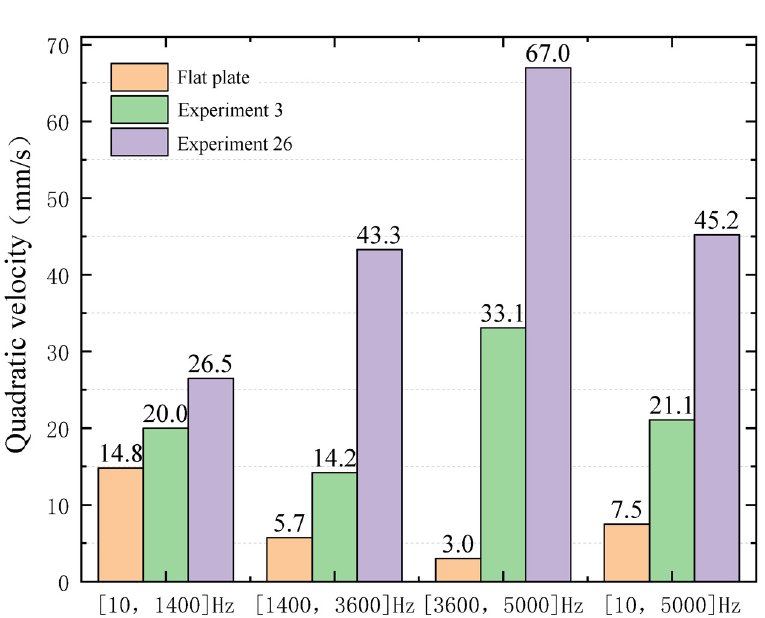
Figure 13. The average quadratic velocity of three experiments under different frequency regions.